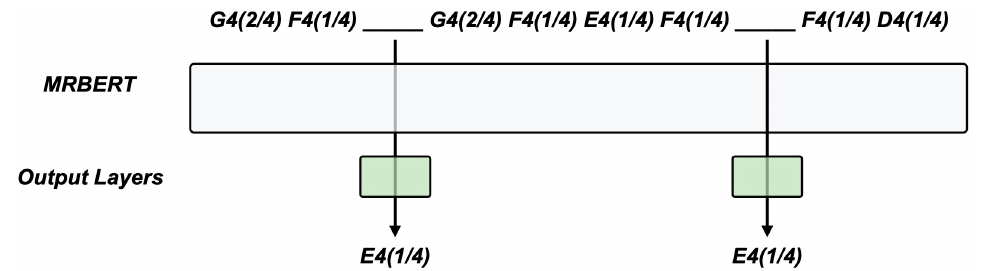
Figure 4. Pipeline of conditional generation. The underline represents the missing part of the music.